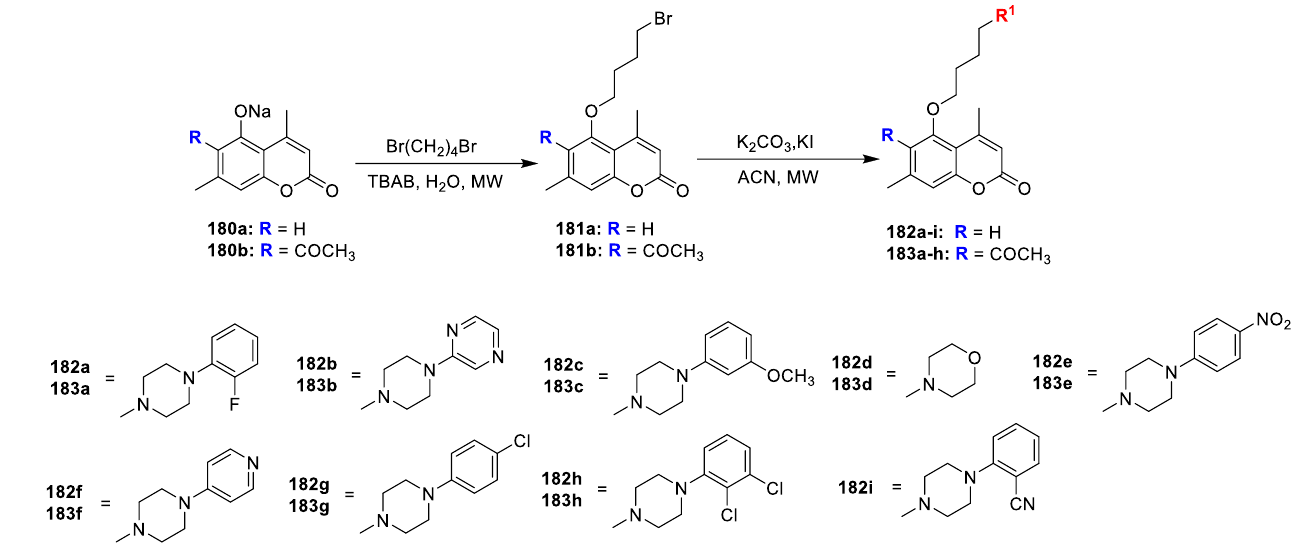
Scheme 41 . Route for the development of 5 - [4-(4-aryl-1-piperazinyl) butoxy] coumarins. Repro- duced and adapted with permission from ref. 57. Copyright 2016, Springer